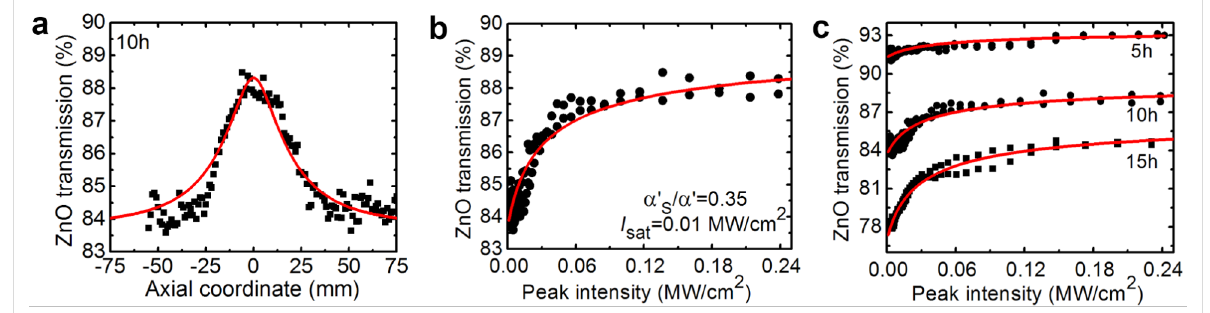
Figure 4: Absorption saturation of ZnO nanorods (NRs): (a,b) NRs grown for 10 h, (a) open-aperture Z-scan experiment and (b) the corresponding absorption saturation curve (measured at 1.06 μ m under ps excitation), points – experimental data, red curve – fitting; (c) comparison of the absorp- tion saturation curves for NRs grown for 5–15 h. The data plotted in (b) are adapted from [28].